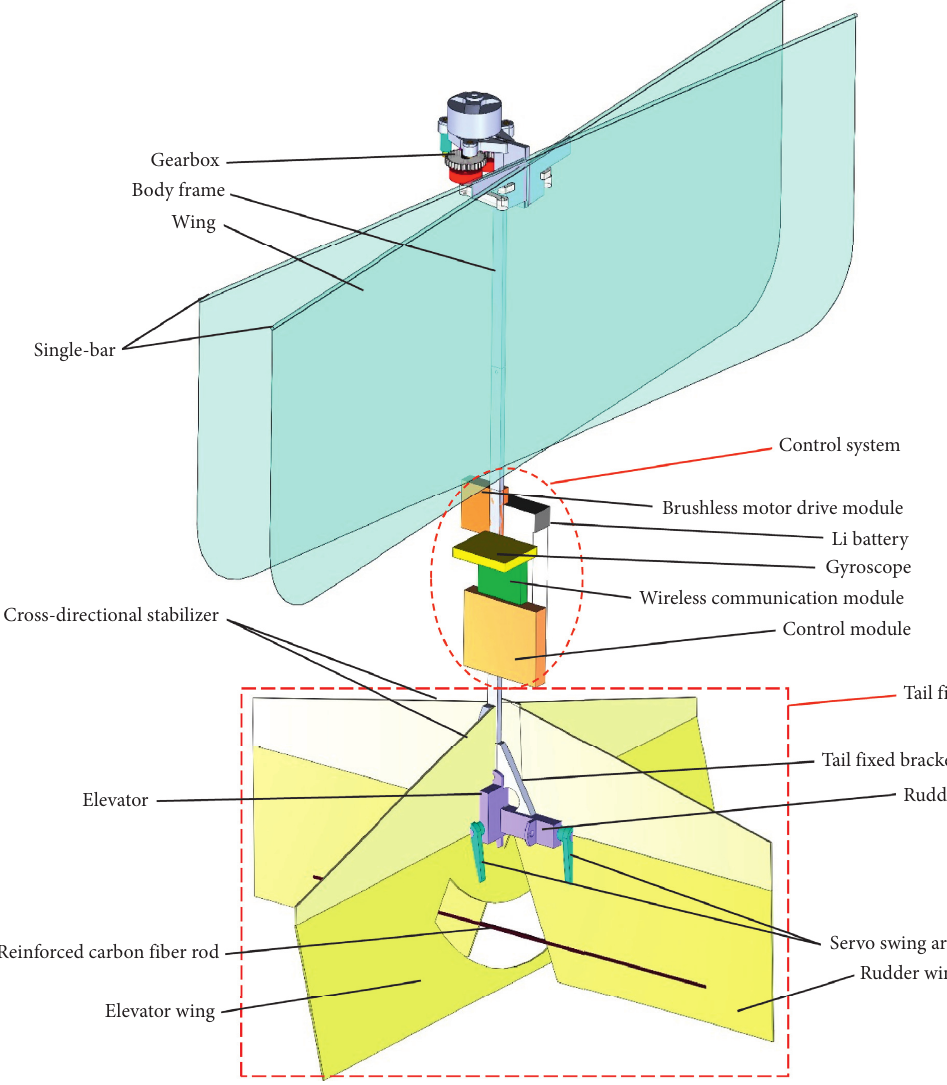
Figure 6: The overall structure of the X-shaped